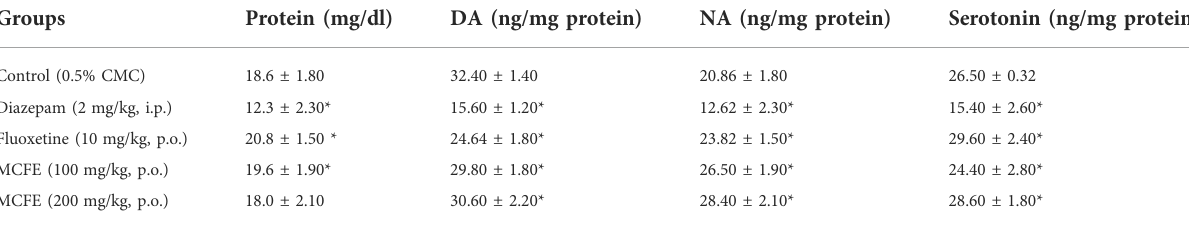
TABLE 3 Measurement of protein, DA, NA and seratonin levels in mice brain on chronic administration of MCFE. Groups